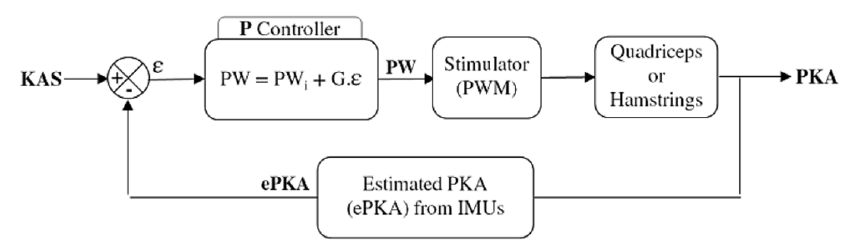
Figure 2. Closed-loop control of the thigh muscles. A P controller modulates the pulse width of the stimulator depending on the error between the knee angle setpoint (KAS) and the estimated paretic knee angle (ePKA) from the IMUs quaternions during stance phase. An initial pulse width ( PWi ) and a gain G are set for each participant depending on his knee issue.